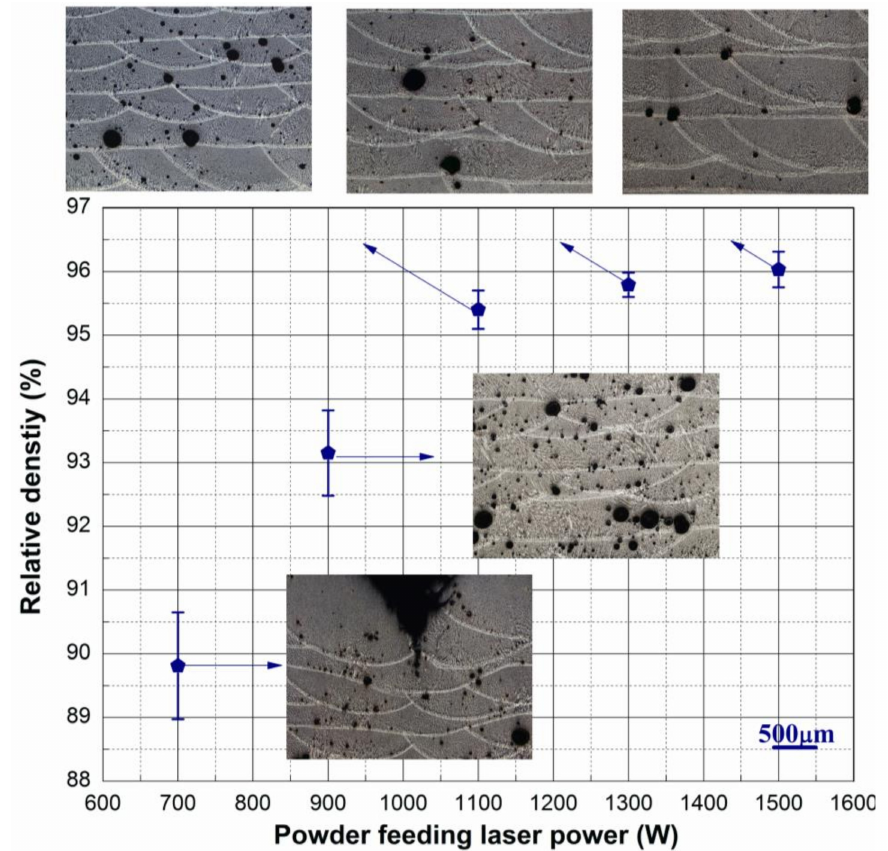
Figure 2. Metallographic images of the XZ section and plot showing the e ff ect of powder feeding laser power on the relative